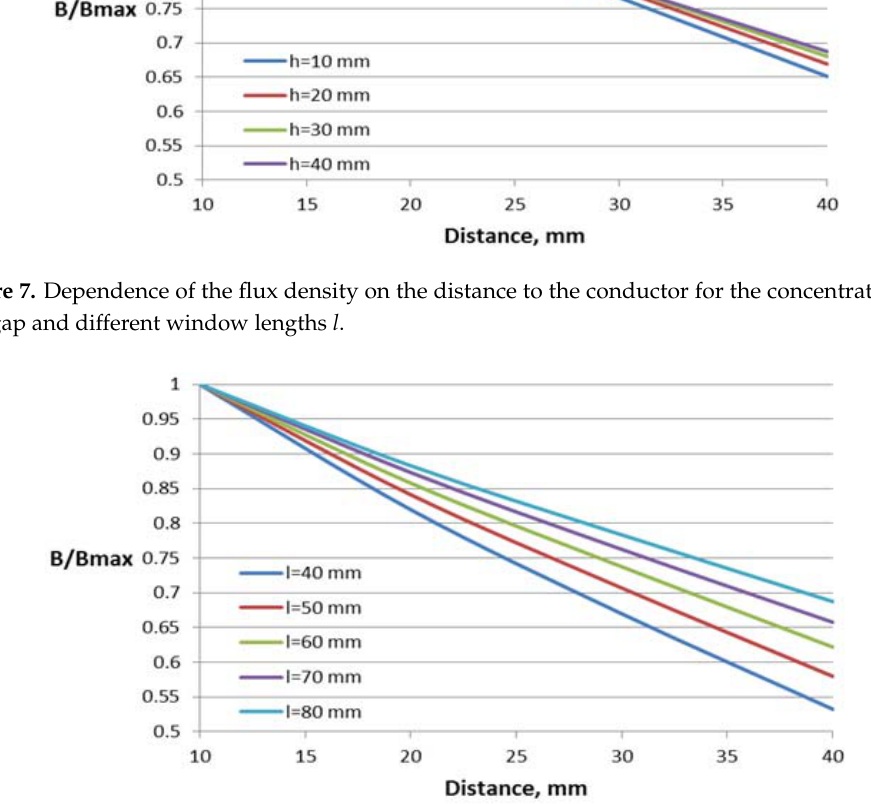
Figure 8. Dependence of the flux density on the distance to the conductor for the concentrator with one gap and different window heights h .